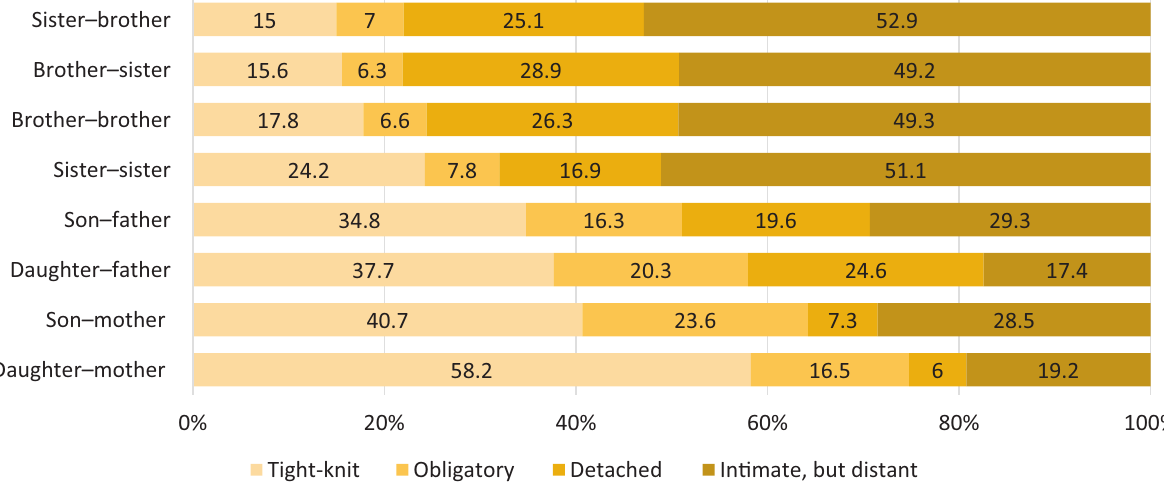
Figure 3. Solidarity within and between generations in Lithuania. Notes: The typology of relationships developed based on the information about 719 sibling dyads and 602 adult child–parent dyads (1322 dyads in total); the respondent is pre‐ sented as the first part of the dyad (for example, the sister–brother dyad indicates that it refers to a relationship between the female respondent and her brother). Source: Data derived from the 2018 representative survey Migration and Family Processes: Representative